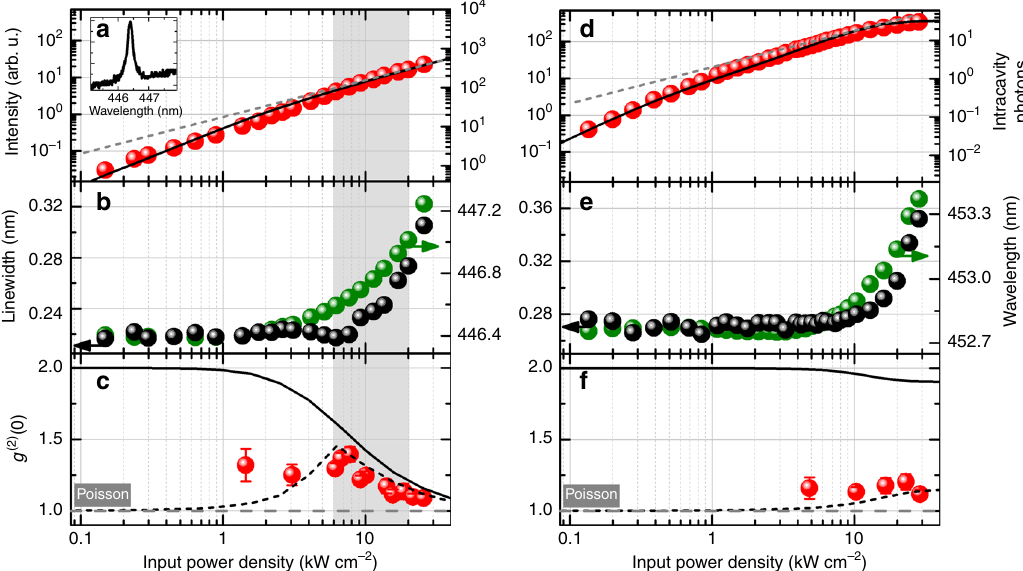
Fig. 2 Room temperature optical and quantum-optical characterization of a lasing and a non-lasing III-nitride nanobeam cavity. a , d Room temperature I – O curves. The theoretical model (solid line) in a shows a slight nonlinearity before converging to a slope of 1 (indicated by the dashed line). Inset in a : Fundamental cavity mode at 0.64 kW cm − 2 . The I – O characteristic in d is governed by non-radiative losses and does not show an s-bend before saturating. The increased output intensity with respect to a is indicative of an increase in light scattering towards the vertical direction. Note that the intracavity photon number is higher for the lasing nanobeam, which allows building up a coherent photon population. b , e Resonance peak wavelength (green) and linewidth (FWHM, black). Above about 10 kW cm − 2 the development of resonance wavelength and emission linewidth is dominated by heating of the cavity region. The lasing structure in b exhibits a slight decrease in linewidth around P ≈ 5 kW cm − 2 . c , f Second-order autocorrelation function at zero time delay as obtained from experiment (data points) and theory. Proof of the transition to coherent emission (shaded excitation range) is provided by the power dependence of the deconvolved second-order autocorrelation data, showing a clear trend towards the Poisson limit ( g (2) (0) = 1) with increasing excitation power density. In contrast, the power dependence in f reveals a constant g (2) (0) ≤ 1.2. The evolution of the photon statistics is well reproduced by the microscopic theory (ideal: solid line, convolved: dashed line), when taking into account the calculated coherence time and the convolution with the temporal resolution (~225ps) of the HBT setup. Error bars in c and f indicate the standard deviation obtained from fi tting the recorded histograms that mirror g (2) ( τ